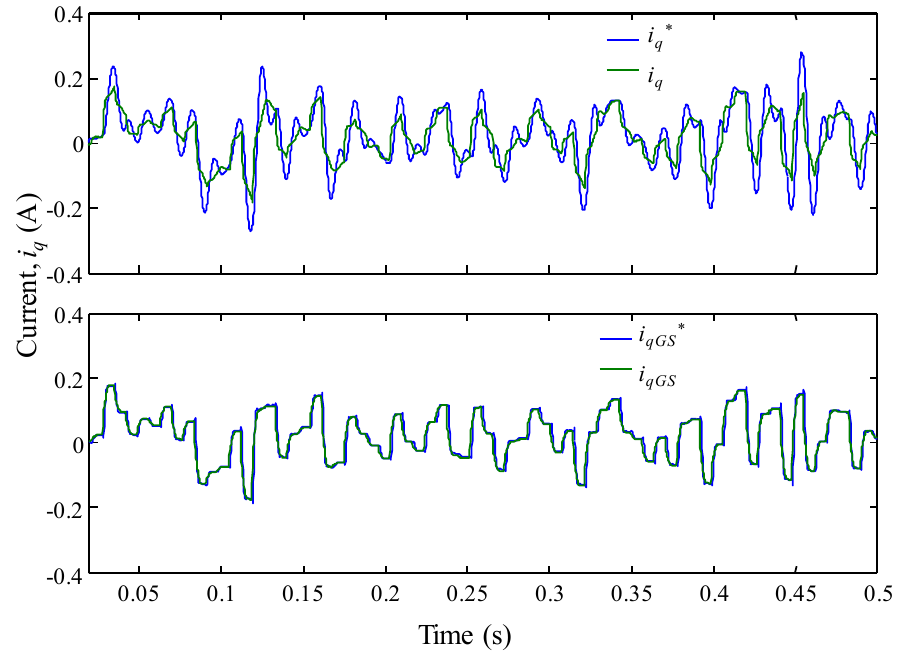
Figure 16. q axis current obtained with the two different controllers in the presence of a current disturbance corresponding to FVLs.